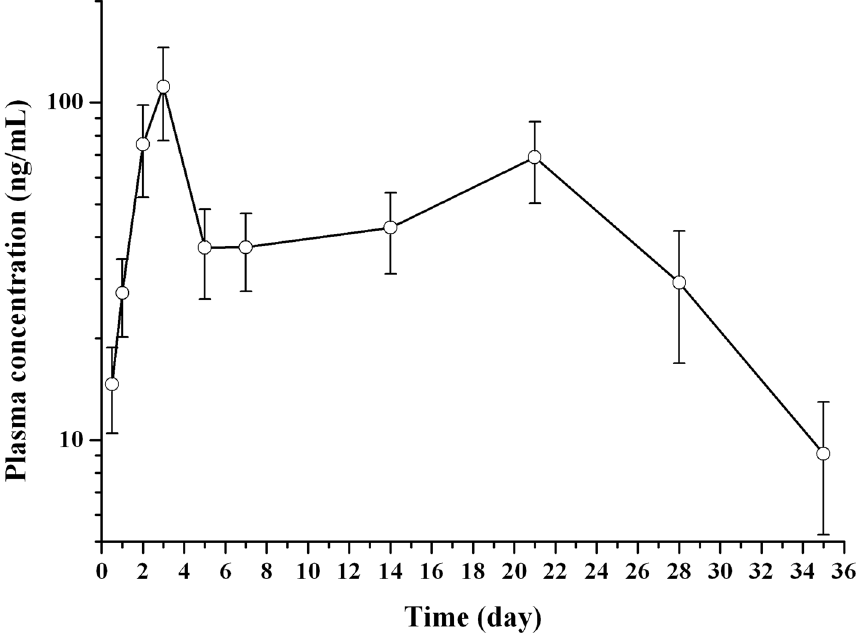
Fig 7. Mean plasma drug concentration-time curve of nalmefene in rats following the single subcutaneous injection of drug loaded microspheres (n = 6).